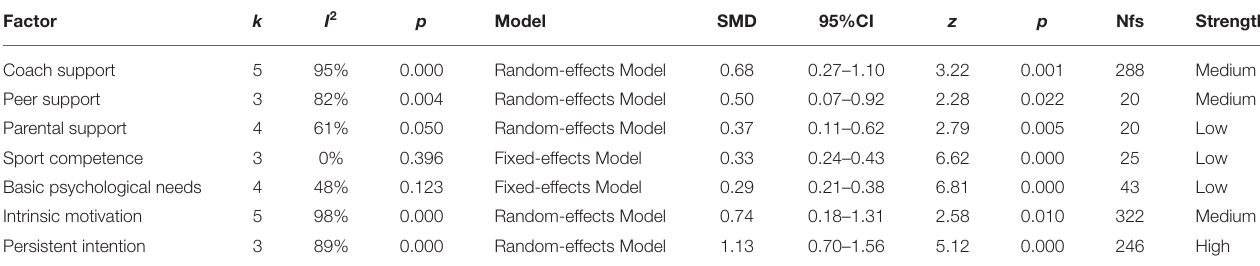
TABLE 6 | Meta-Analysis of factors related to persistent participation behavior.